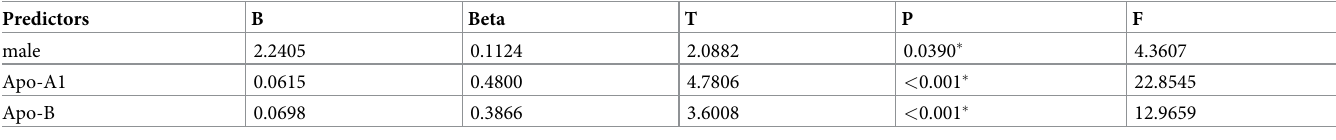
Table 3. Model 1. Multiple regression analysis to analyze the contribution of each predictor including Apo-B in predicting the %NC (n = 115).